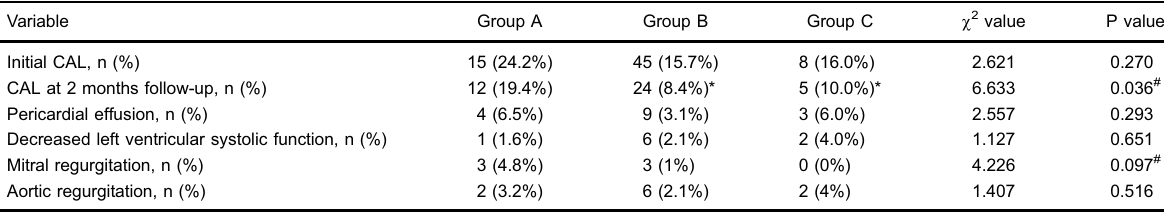
Table 4. Echocardiographic fi ndings in the different Kawasaki disease age